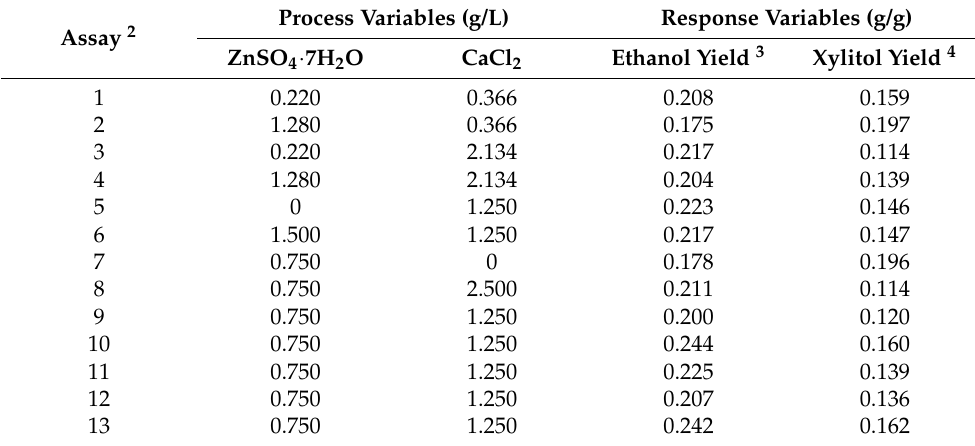
Table 1. Experimental design 1 used to obtain the maximum ethanol yield